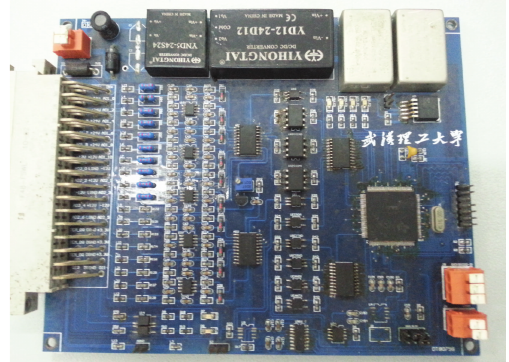
Figure 3: Measurement unit.